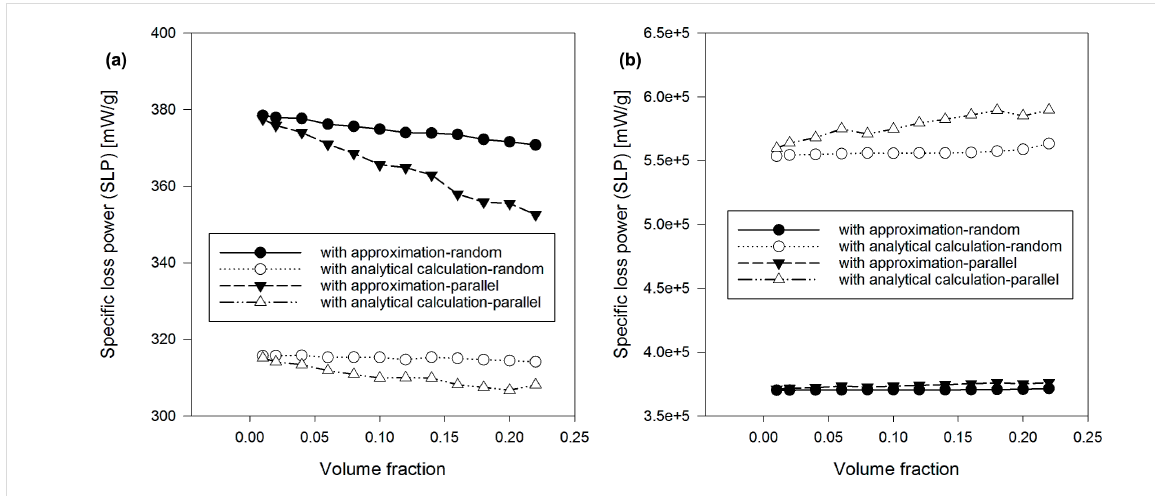
Figure 3: SLP vs volume fraction of nanoparticles: (a) diameter 7 nm, (b) diameter 17 nm.